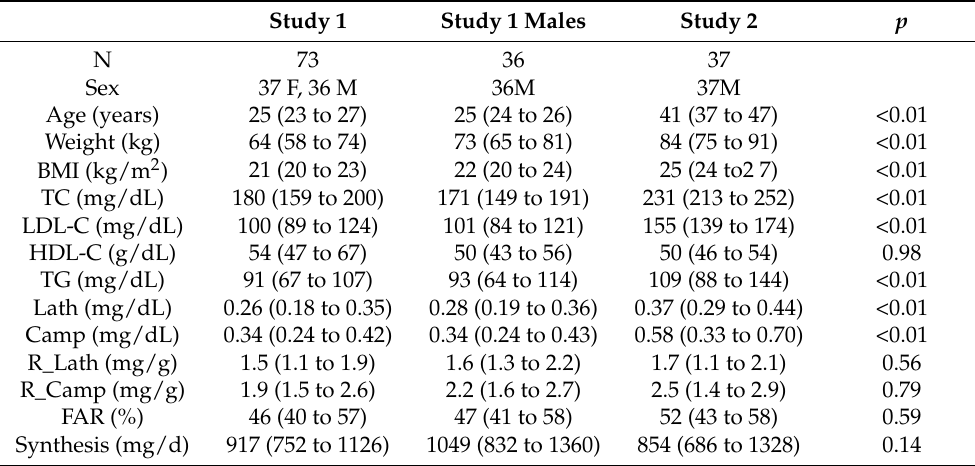
Table 3. Comparison of subject characteristics, serum lipids, marker concentrations, marker ratios, FAR and synthesis for male subjects of study 1 and 2. Data are expressed as number of subjects or as median and interquartile range (25th and 75th percentile). The statistical difference was tested with the Mann Whitney U Test. TC = total cholesterol, LDL-C =low density lipoprotein cholesterol, HDL-C =high density lipoprotein C, TG = triglycerides), Lath = lathosterol, Camp = campesterol, FAR = fractional absorption rate (%). Study 1 Study 1 Males Study 2 p N 73